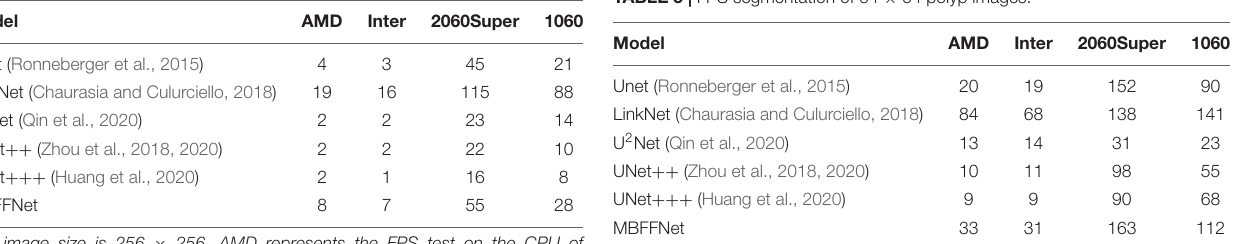
TABLE 4 | 256 × 256 polyp image segmentation